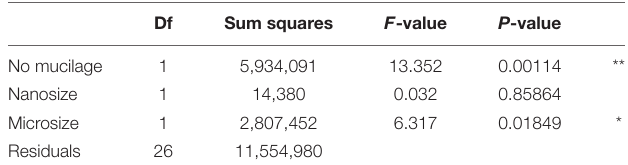
TABLE 3 | Correlation of bacterial richness with functional groups of algae selected according to the results of model selection by AIC; Signif. codes: ** p < 0.01, * p <